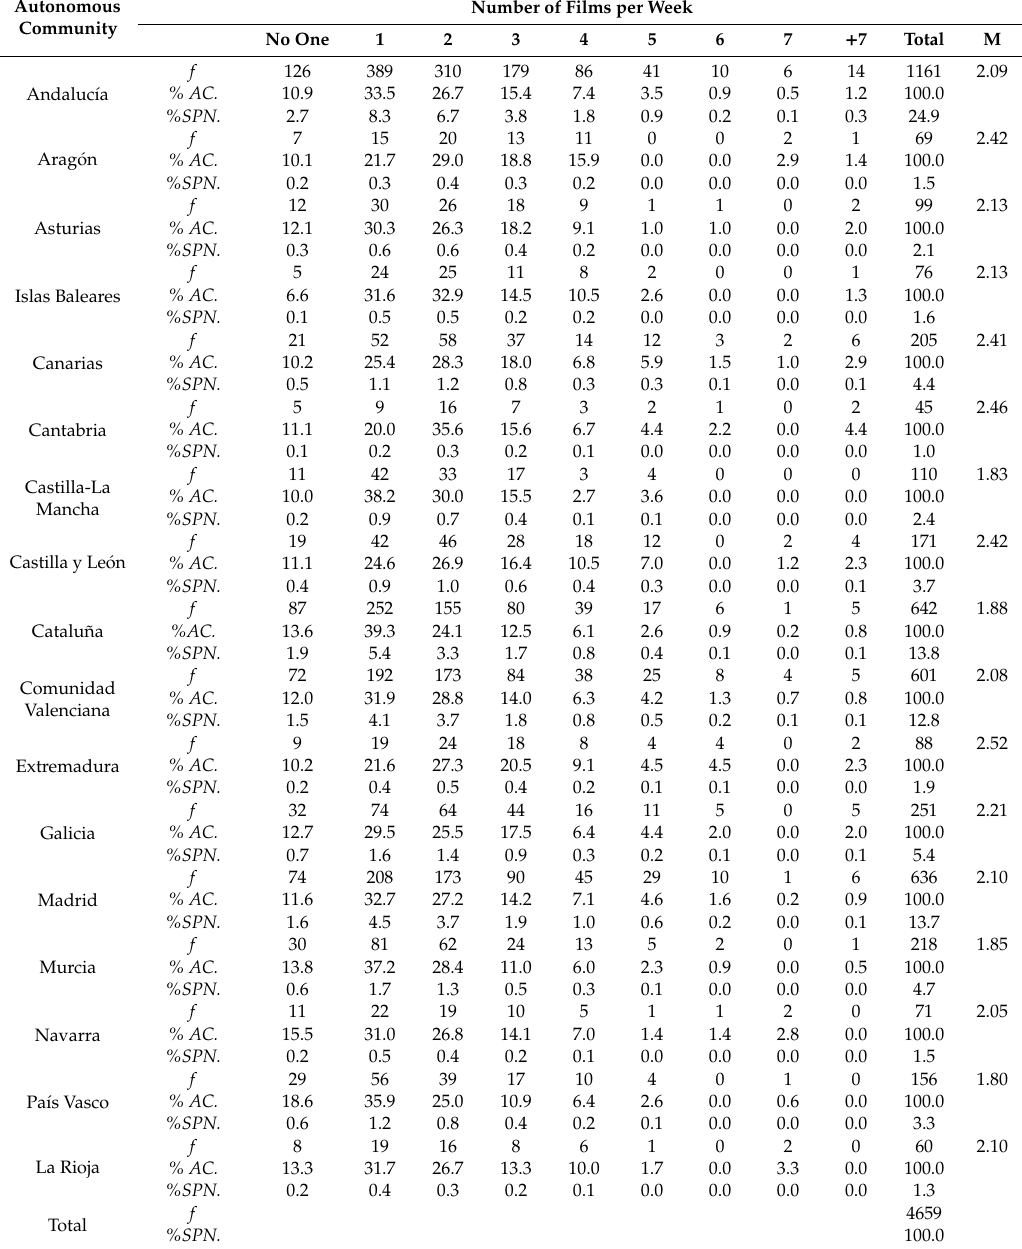
Table 2. Percentages and frequencies of the number of films viewed, according to the Autonomous